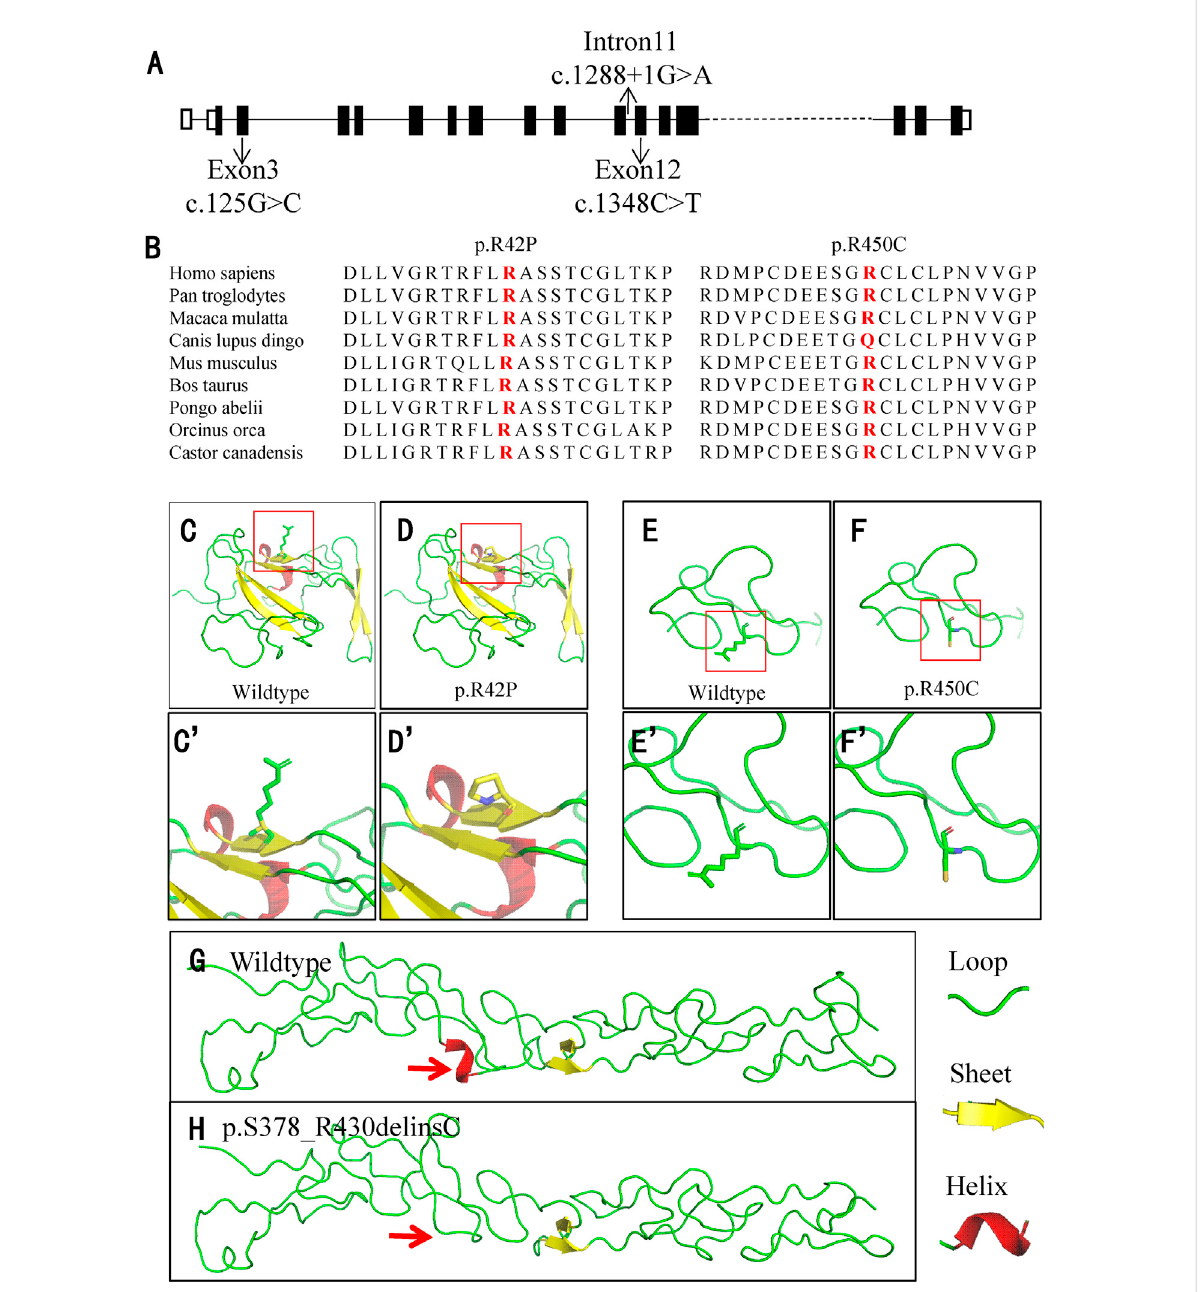
FIGURE 3 Location and conservation analysis of the variants and tertiary structure analysis of the mutant LAMB3 protein. (A) Schematic diagram of LAMB3 and distributionofthevariants. (B) Conservation analysis of theaffectedamino acid inLAMB3 across nine differentspecies. (C – H) Analysis of the tertiary structure in wildtype and mutant LAMB3. The red boxes in (C – F) indicate the position of changes, and they are ampli fi ed in (C ’ -F ’ ) , respectively. Red arrows indicate the differences between the wildtype and mutant